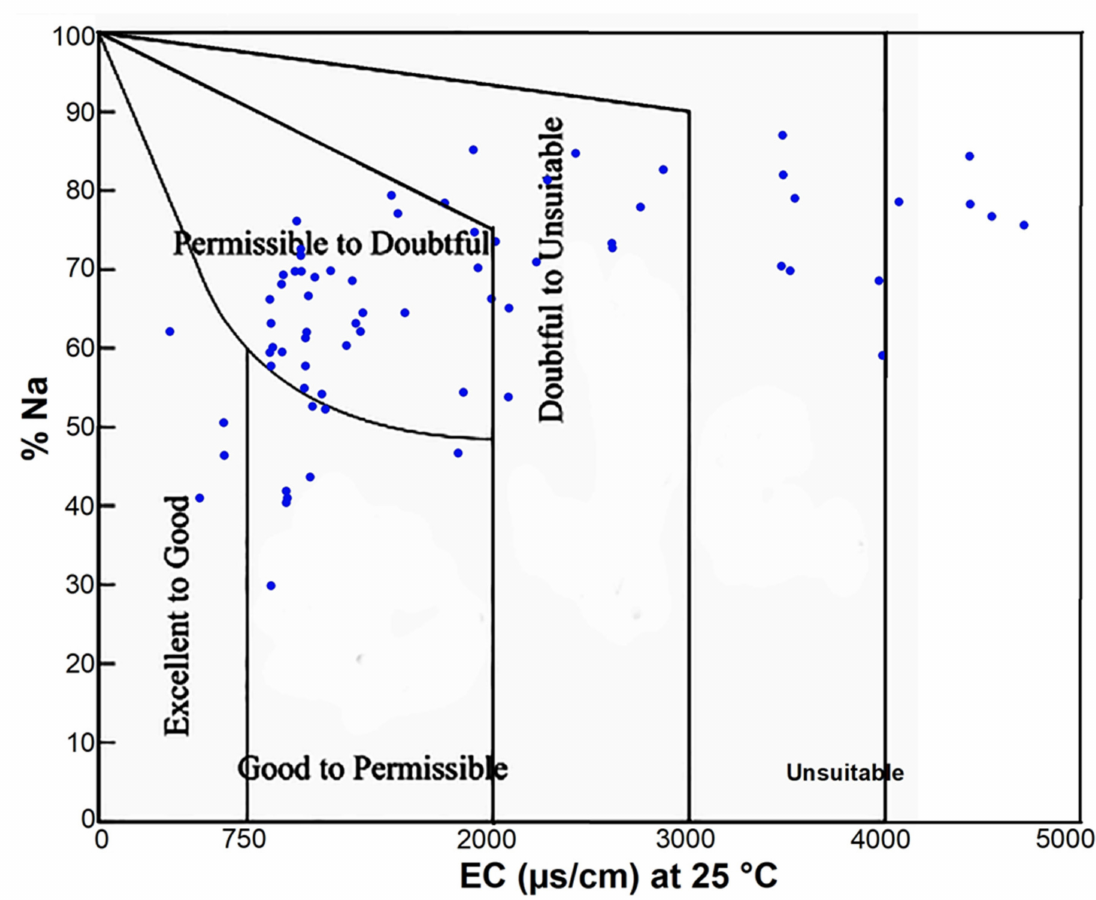
Figure 10. US Salinity Lab (USSL 1954) classification of groundwater for irrigation. The Na% values ranged between 30% and 92%. The IDW interpolation surface map of Na% in the study area was classified using the USSL thresholds: normal (<60) green color, moderate (61–70) yellow color, high (71–80) brown color, and very high (>80) light pink color. The spatial map exhibited that the Na% normal class occurs in the northeastern part of the study area (Figure 11). The Na% moderate class occupies a narrow zone east of the Cairo–Alexandria highway. The Na% high covers the central part west of Cairo–Alexandria highway and a narrow strip along the highway. There is a spike of the Na% high class in the central northern part around wells 44, 55, 56, and 58. Another spike of Na% high class extends east of the Cairo–Alexandria highway around wells 14, 15, and 41. The Na% very high class covers the northwestern and southwestern parts west of the Cairo–Alexandria highway. There are 3 spikes around wells 16, 19, and 20 (Figure